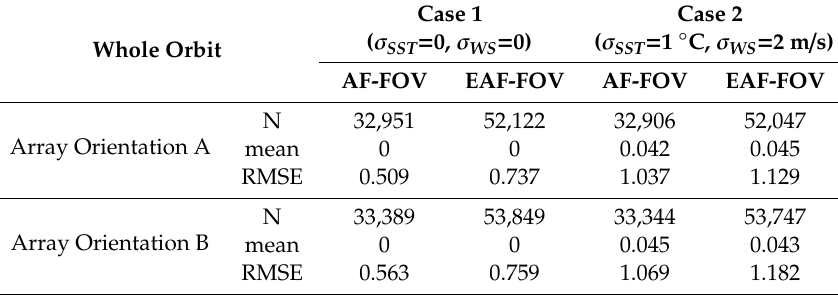
Table 2. The statistics of SSS retrieval accuracy of the whole pass for different array orientations of case 1 and case 2.